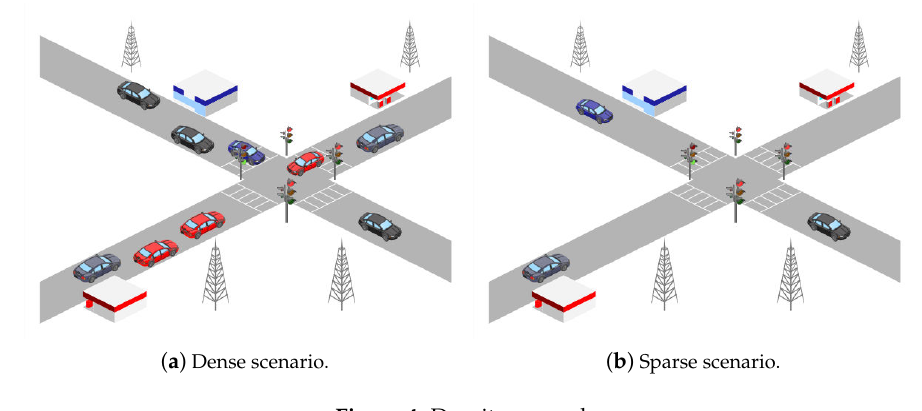
Figure 4. Density